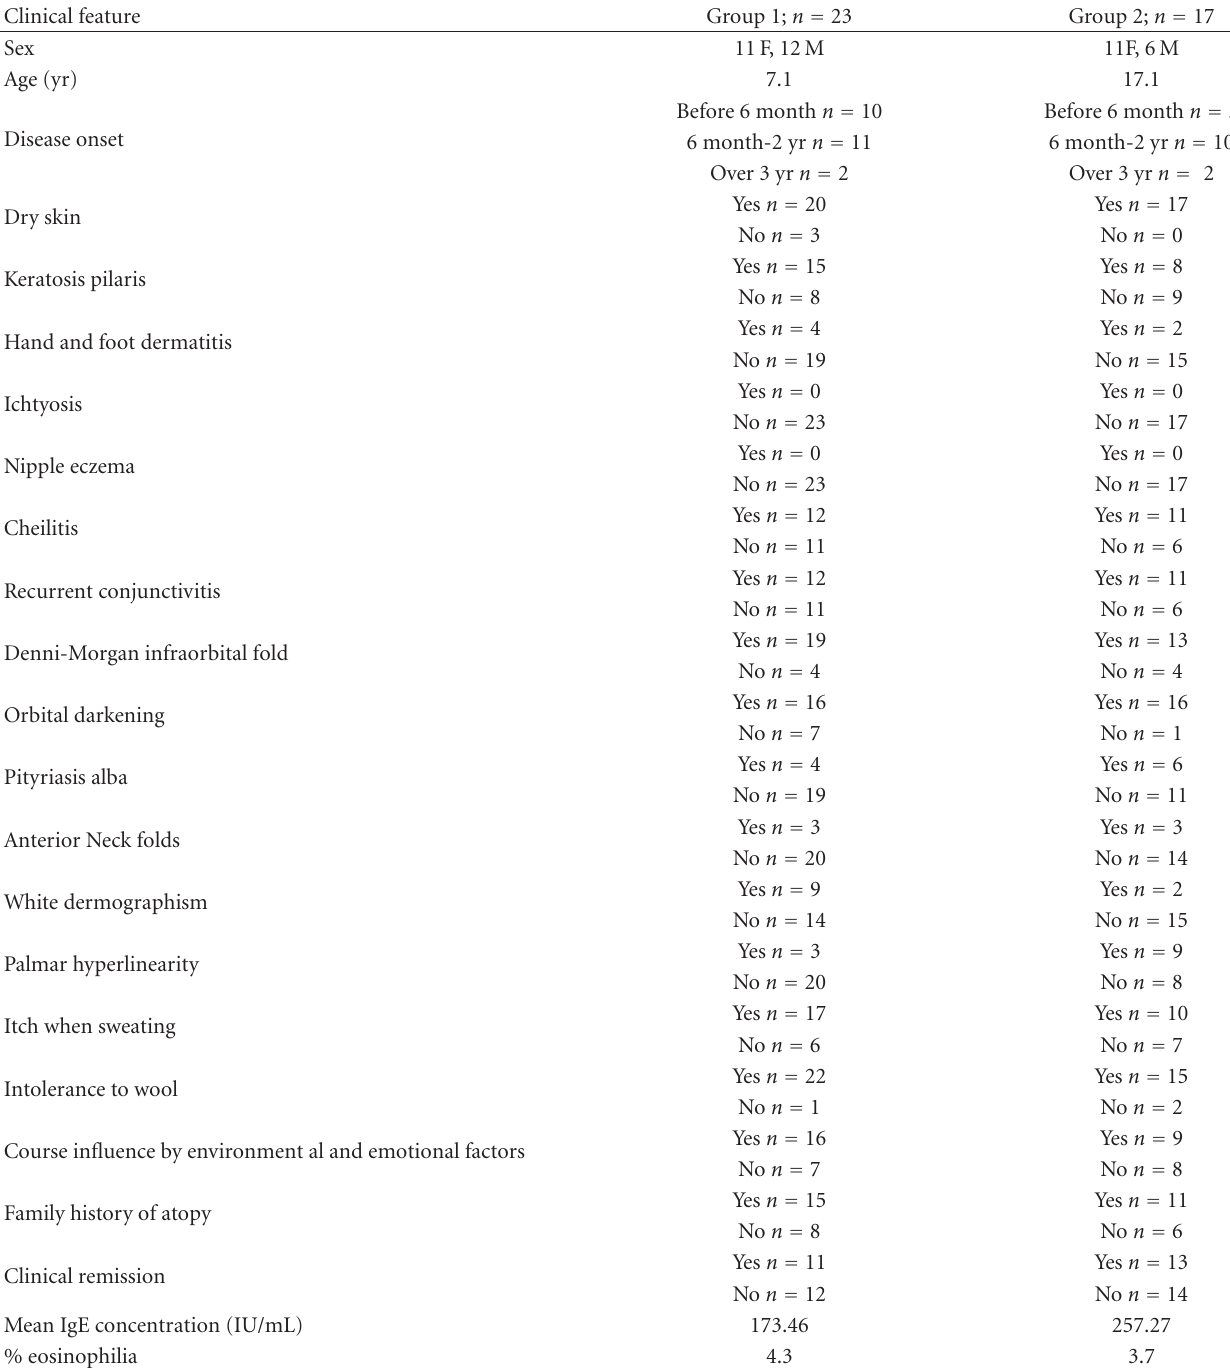
Table 1: Clinical chatacteristics of AD